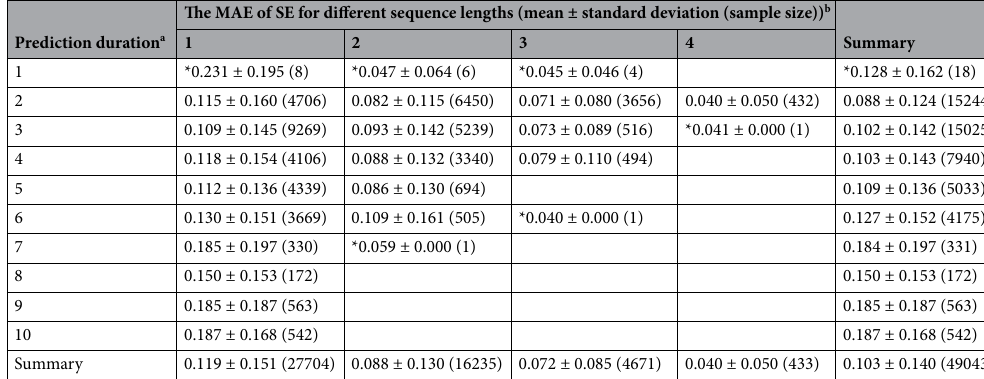
Table 4. The MAE of SE in the testing set for T-LSTM. a A value i means the duration ranges from i − 1 quarters to n quarters. b *Represents that the sample size is too small ( < 100 ) to be a solid reference.